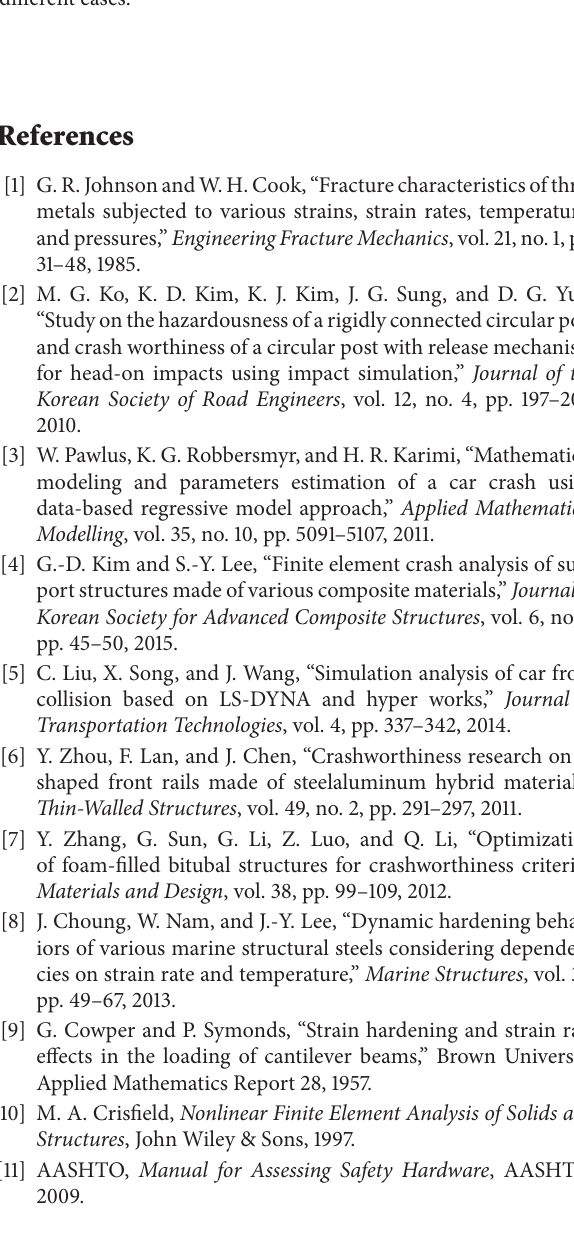
Figure 17: PHD for different